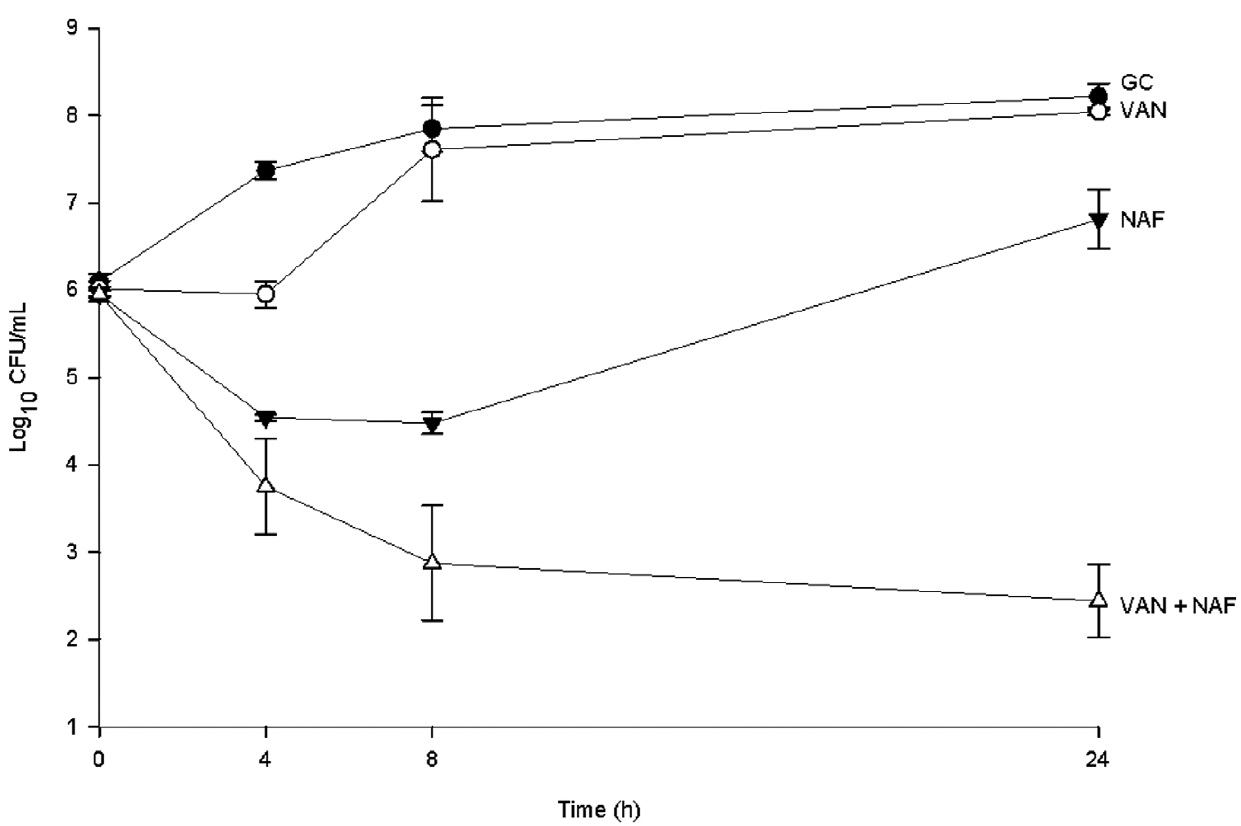
Figure 1. Time–kill curve analysis of one hVISA (R3003, VAN MIC=2, NAF MIC=256 m g/mL) isolate. All antimicrobials are at a concentration of 0.5x MIC. This isolate shows synergy between vancomycin and nafcillin. Data are presented as a graph of the mean bacteria remaining vs. time with error bars at the sampling points representing 1 standard deviation from the mean. GC=Growth Control, NAF=Nafcillin, VAN=Vancomycin.